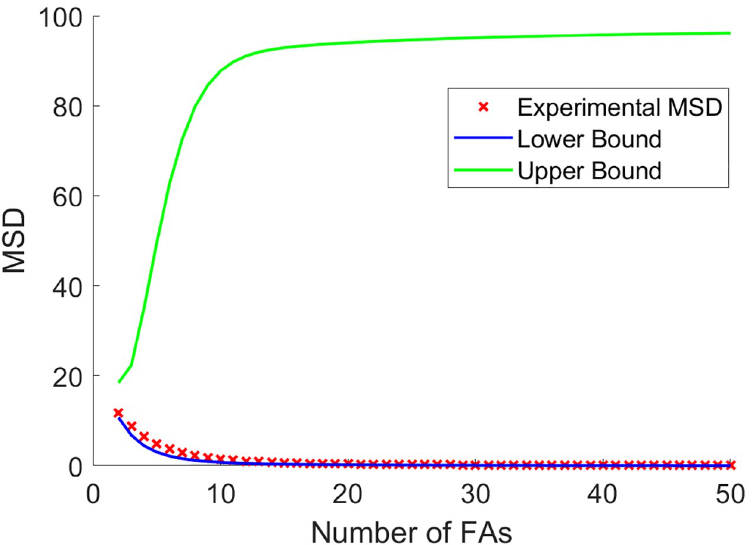
Fig 6. Upper bound for the MSD. An upper bound for the MSD is found using the values for the centroid displacement found in Eq (17). A trajectory of 100,000 data points with r = 1 was used to approximate the MSD.